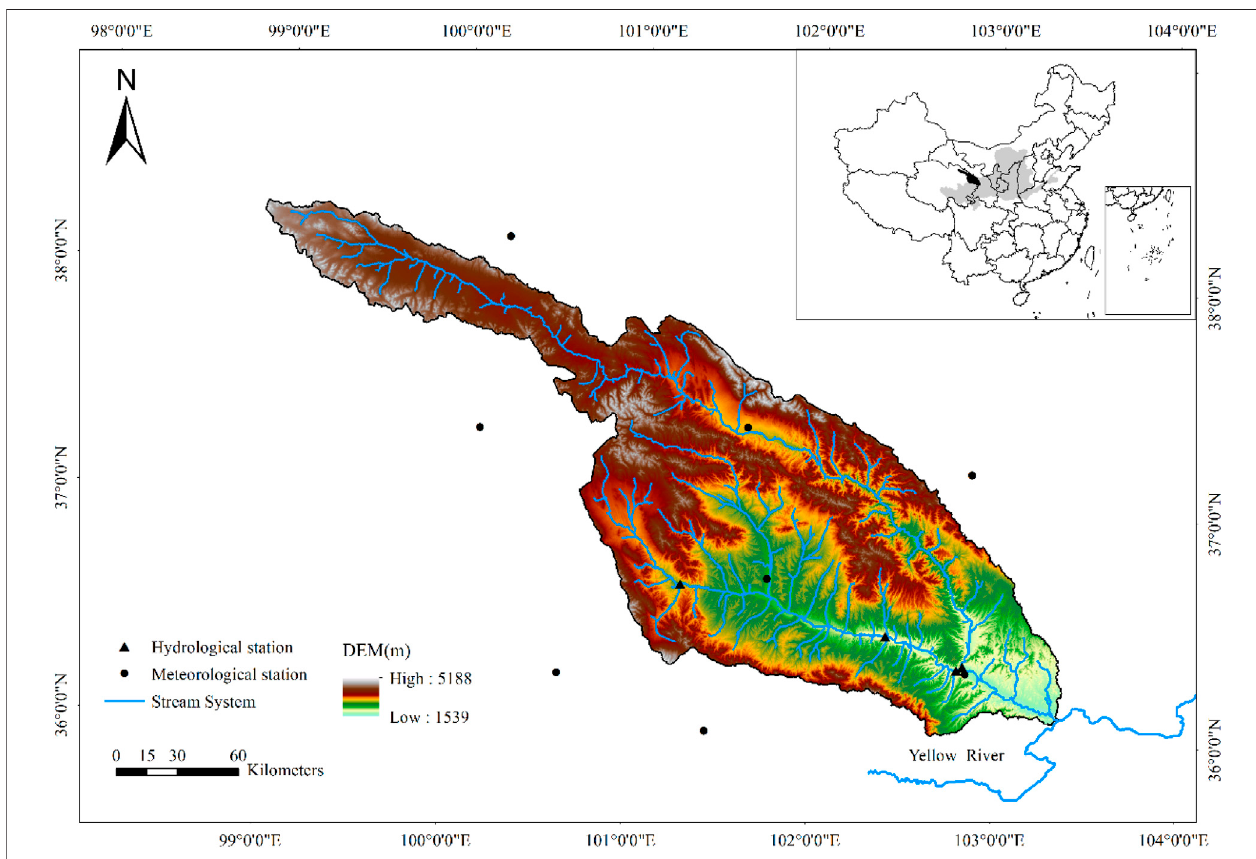
FIGURE 1 | Location of the Huangshui River basin and hydrological and meteorological stations.